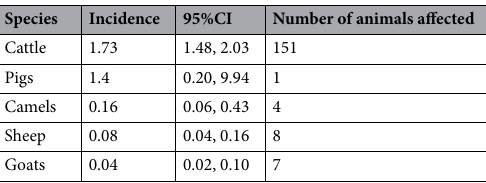
Table 2. Species-specific incidence (95% CI) of anthrax outbreaks ranked per 100,000 animals per year.